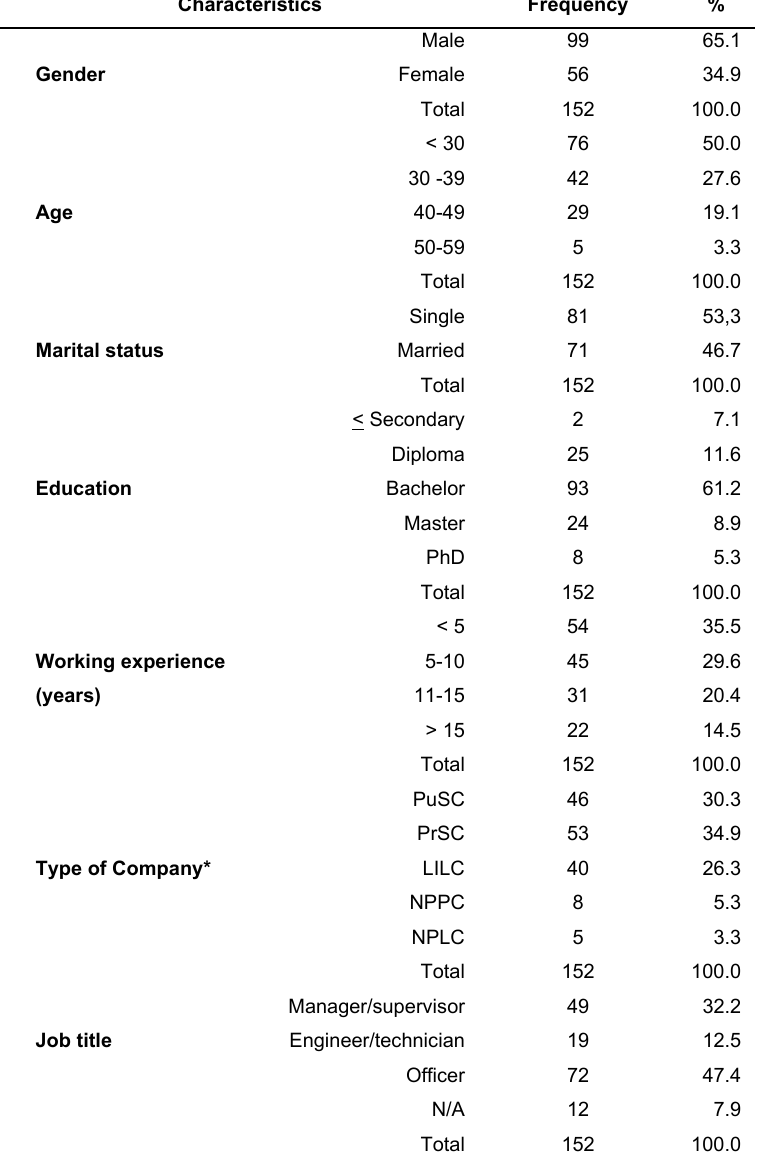
Table 3. The demographic sample